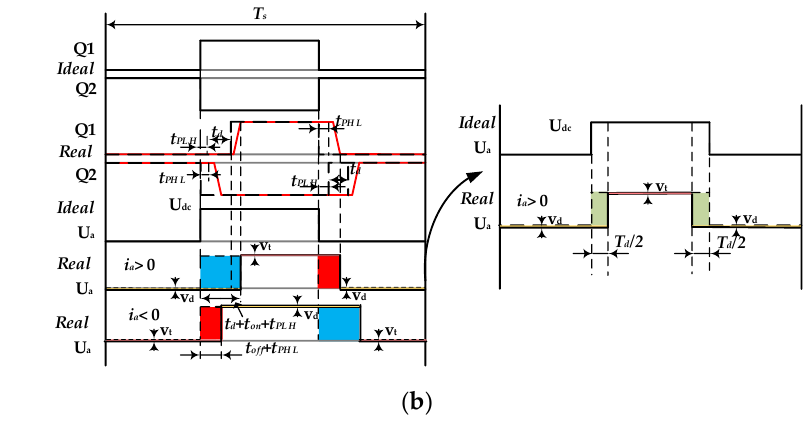
Figure 3. Inverter A-phase bridge arm circuit path and output voltage waveform diagram: ( a ) A- phase bridge arm current path diagram; ( b ) switch signal and output voltage waveform of A-phase bridge arm.